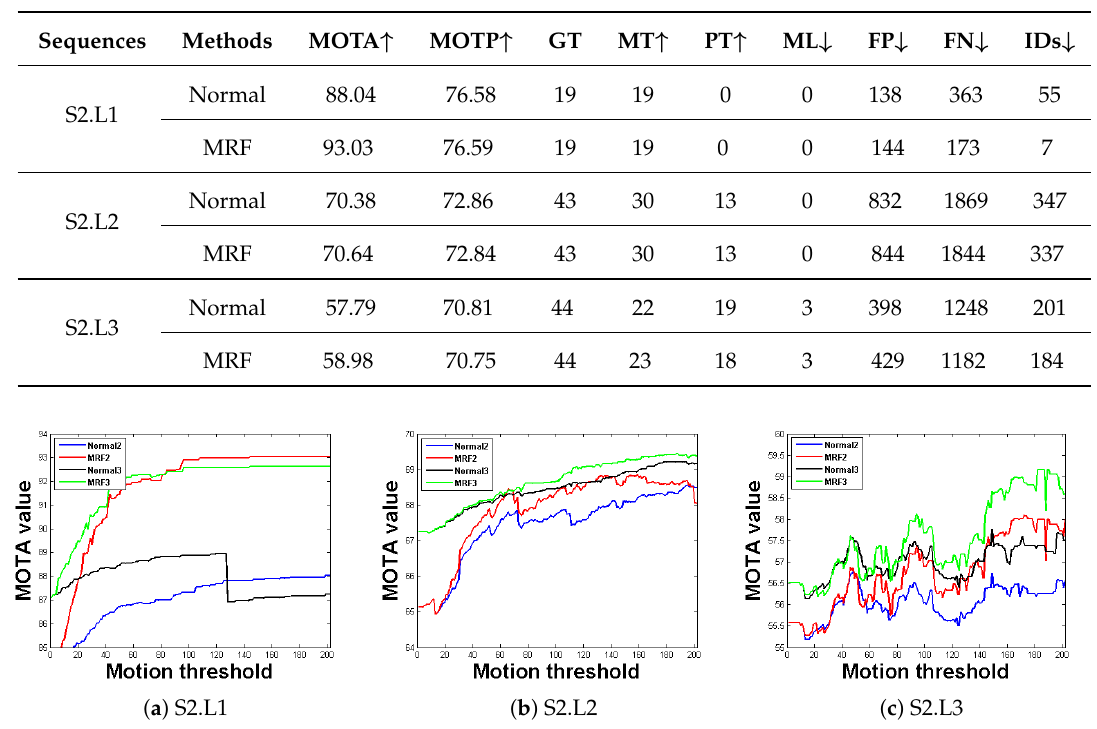
Table 1. Results of comparison between the MRF optimization method and a conventional method.